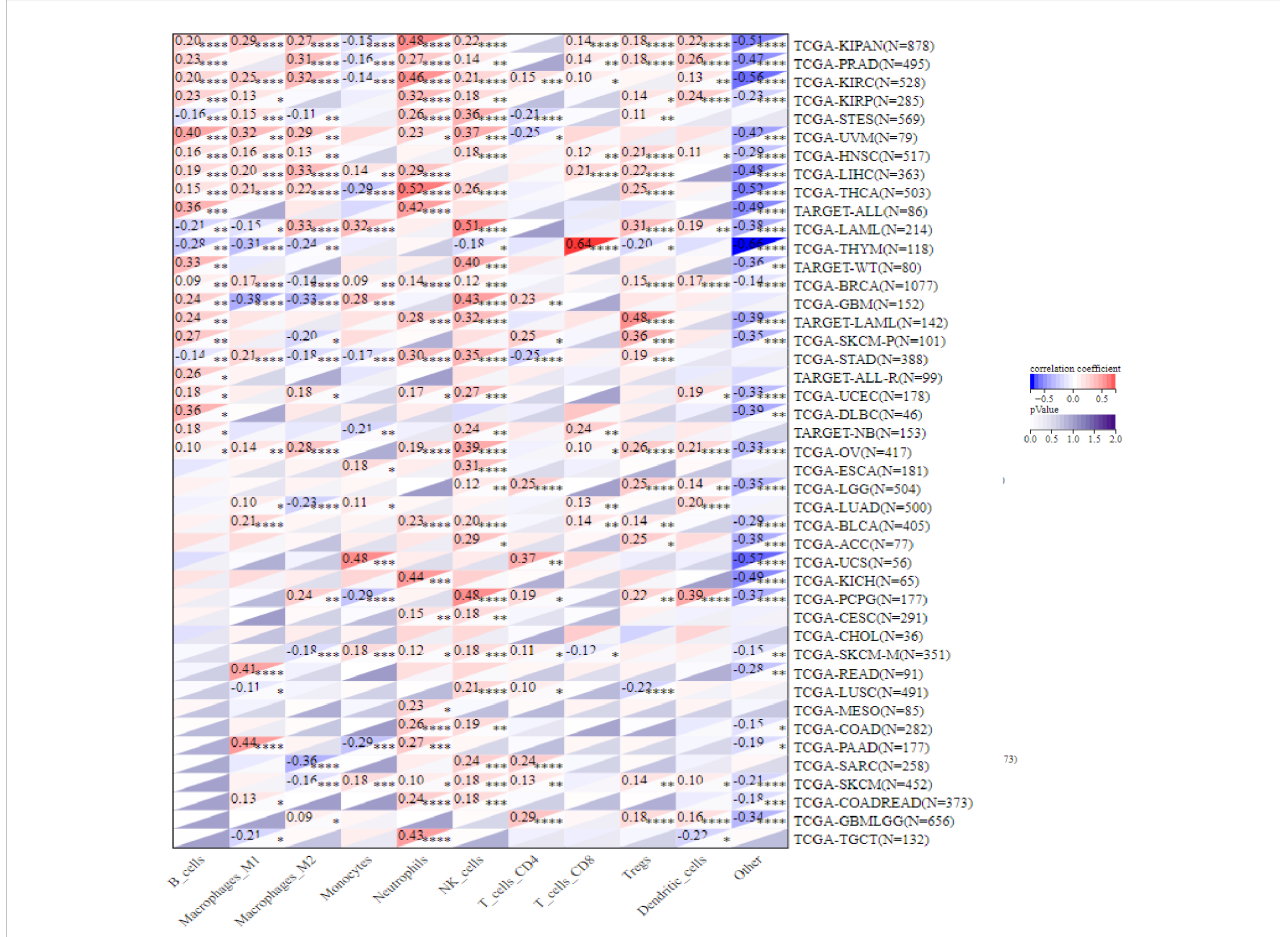
FIGURE 5 Correlation of NCAPG2 with the level of immune in fi ltrating cells. NCAPG2 was closely related to the immune in fi ltration level in cancers analyzed via QUANTISEQ algorithms. *p<0.05; **p<0.01; ***p<0.001;